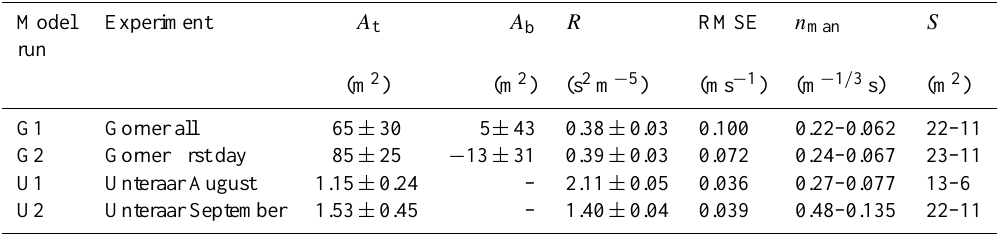
Table 3. Parameters from fitting the model to measurements from Gornergletscher (G1 and G2) and Unteraargletscher (U1 and U2). The fitting parameters and their 95% confidence intervals: A t and A b are moulin cross-sectional area at top and bottom, respectively, and R is channel resistance. The root mean squared error (RMSE) of the fit of ˆ v . Derived parameters for a sinuosity σ of the channel between 1 and 2: manning roughness n man and channel cross-sectional area S .